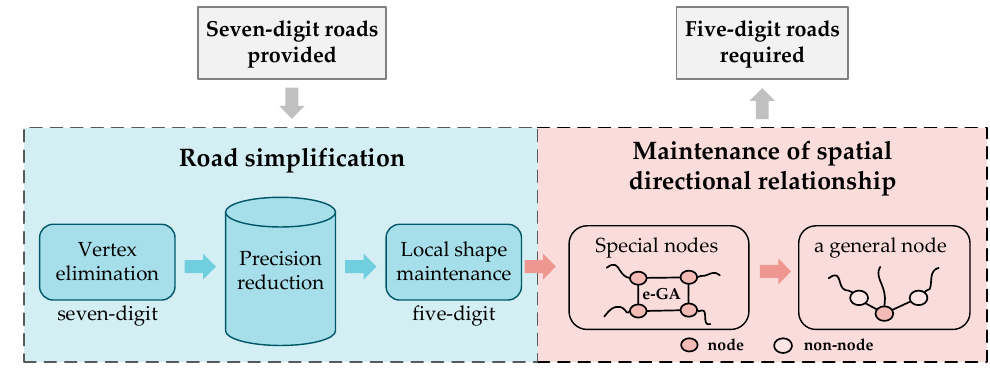
Figure 2. The main steps of our method.